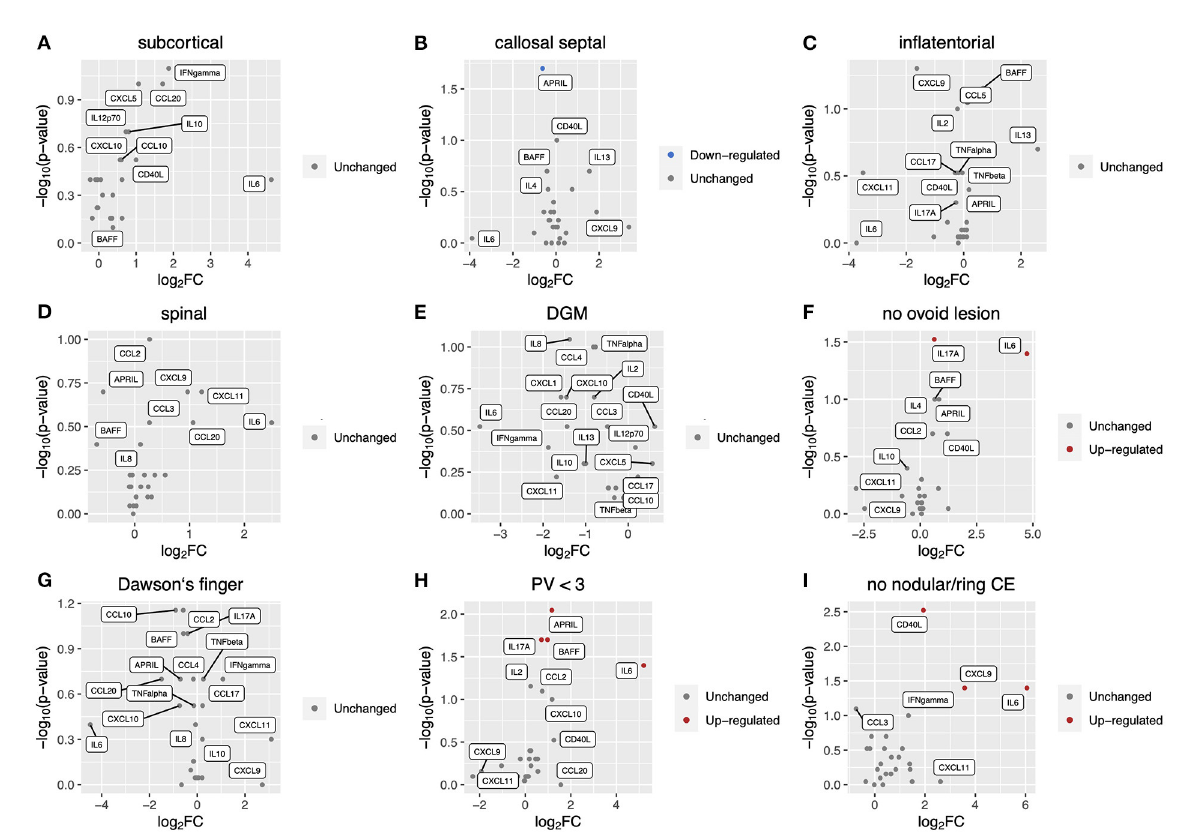
FIGURE1 Correlation of CSF inflammatory profile with radiological findings at MS diagnosis. Volcano plot showing log2 (fold change, FC) against –log10 ( p -value) of CSF inflammatory profile based on radiological findings as follows: (A) , subcortical lesion; (B) , callosal septal lesion; (C) , inflatentorial lesion; (D) , spinal lesion; (E) , DGM lesion; (F) , no ovoid lesion; (G) , Dawson‘s finger; (H) , less than three PV. Red or blue indicates elevation or reduction, respectively, of cytokine/chemokine levels with a significant FC (|FC| > 1.5) and p-value ( < 0.05). CSF, cerebrospinal fluid; MS, multiple sclerosis; DGM, deep gray matter lesion; PV, periventricular lesions; CE,